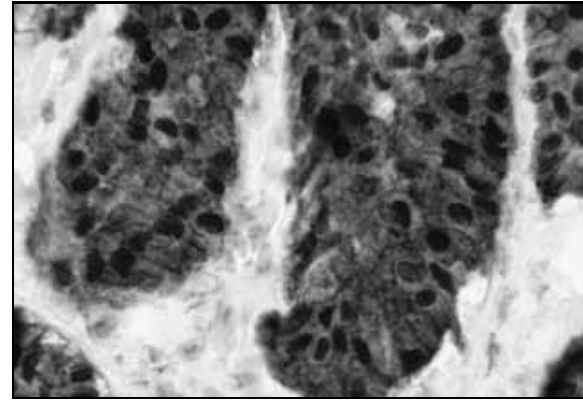
Figura 3D – Imuno-histoquímica para β -catenina demonstrando intensa reação nuclear e citoplasmática em TSPPP (DAB, 400x) TSPPP: tumor sólido pseudopapilar de pâncreas; DAB: